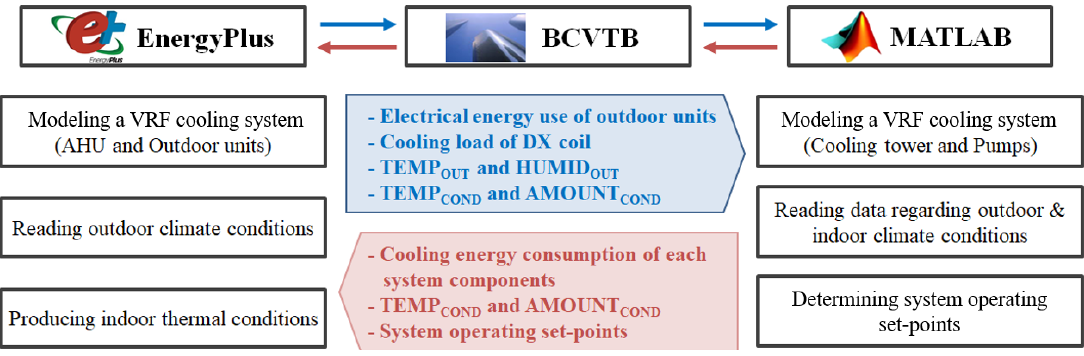
Figure 7. Simulation method using the three software programs.